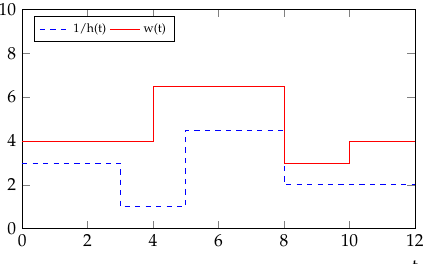
Figure 2. An illustration about the concept of water level w ( t ) , which is a value of the invested power p ( t ) plus a constant 1/ h ( t ) , the multiplicative inverse of the fading factor